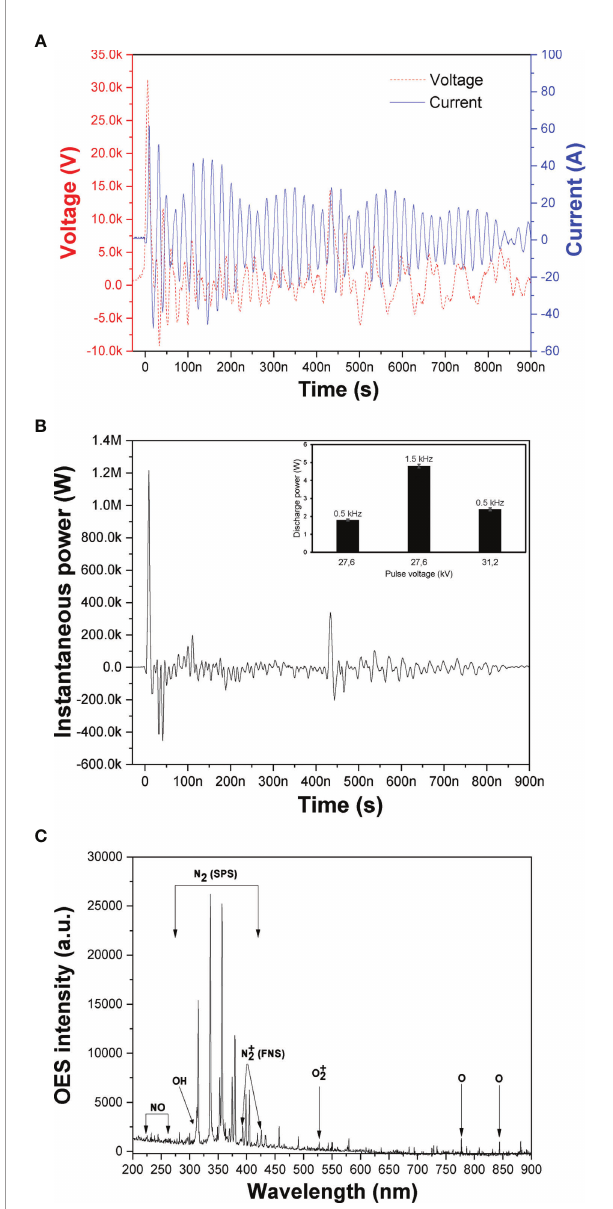
FIGURE 2 | DBD-CAP characterization. (A) Instantaneous voltage and current NSP-DBD signals obtained at V=31.2 kV and f = 0.5 kHz; (B) Instantaneous power signal calculated by multiplying the instantaneous pulse voltage and current (inset: average discharge power as a function of pulse voltage and frequency; (C) Optical emission spectrum to identify the major excited ROS/RNS in the NSP-DBD with air gas.